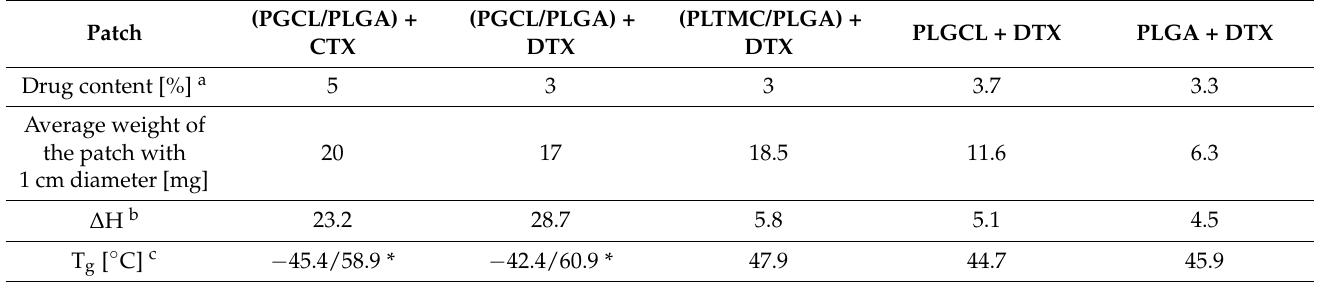
Table 2. Characterization of the patches obtained in the